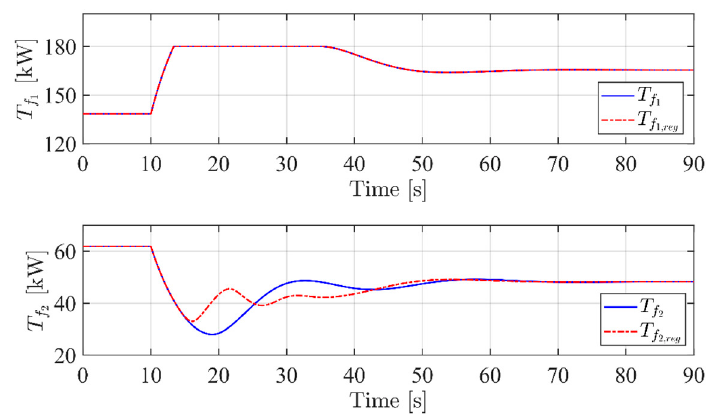
Figure 14. Performance comparison—injected thermal flows.